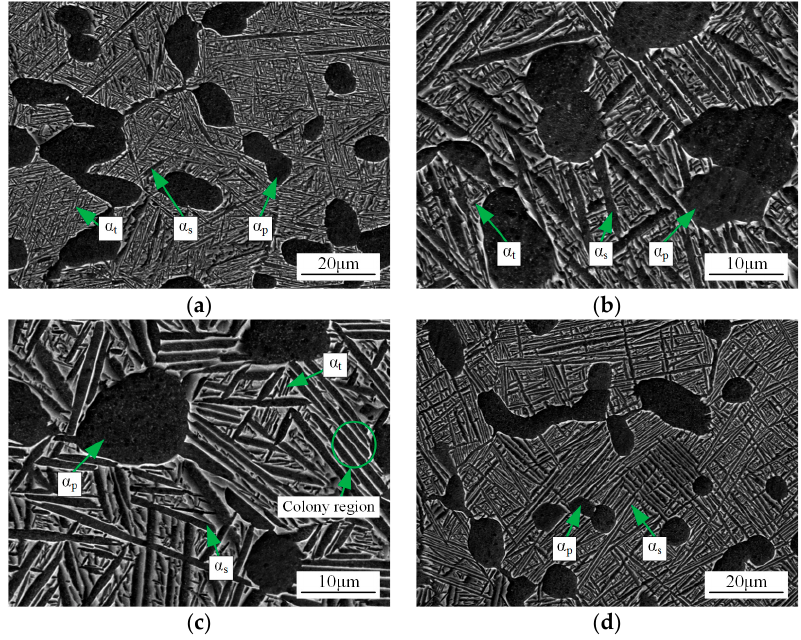
Figure 1. Microstructures of TA15 alloy samples under different heat treatment routes: ( a ) S1, ( b ) S2, ( c ) S3, ( d ) S4. ( c ) S3, ( d )